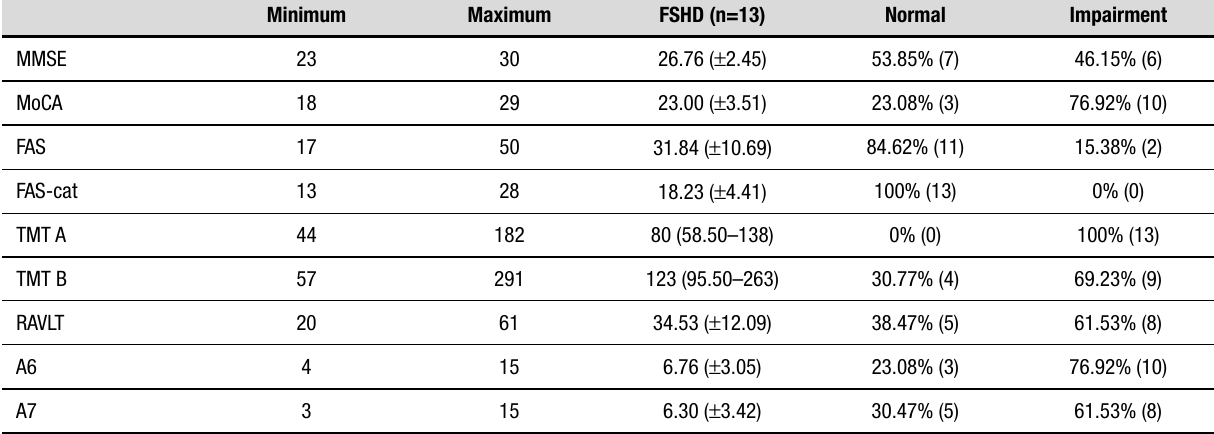
Table 2. Descriptive analysis of cognition scores in the facioscapulohumeral muscular dystrophy group.